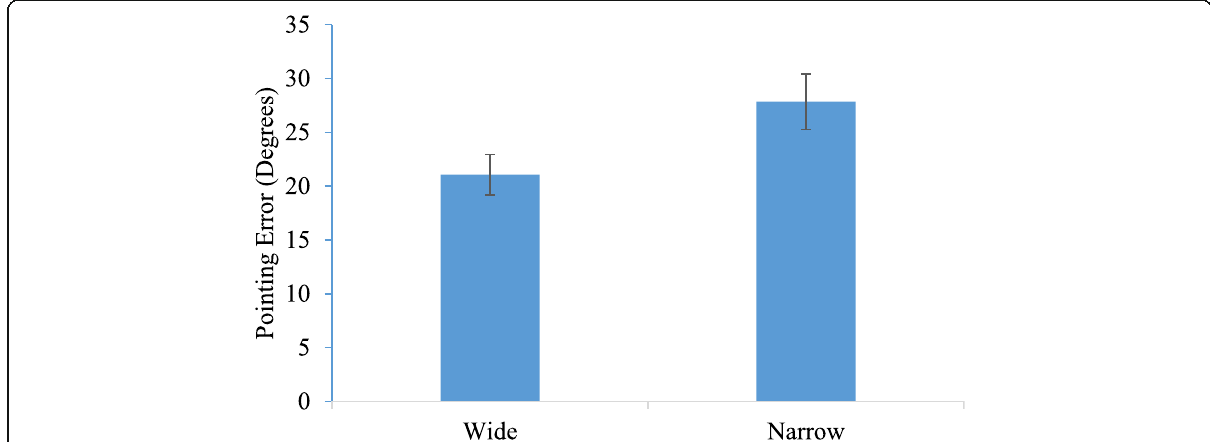
Fig. 2 Comparison of spatial learning error in wide and narrow field of view (FOV) conditions in the Utah Museum of Fine